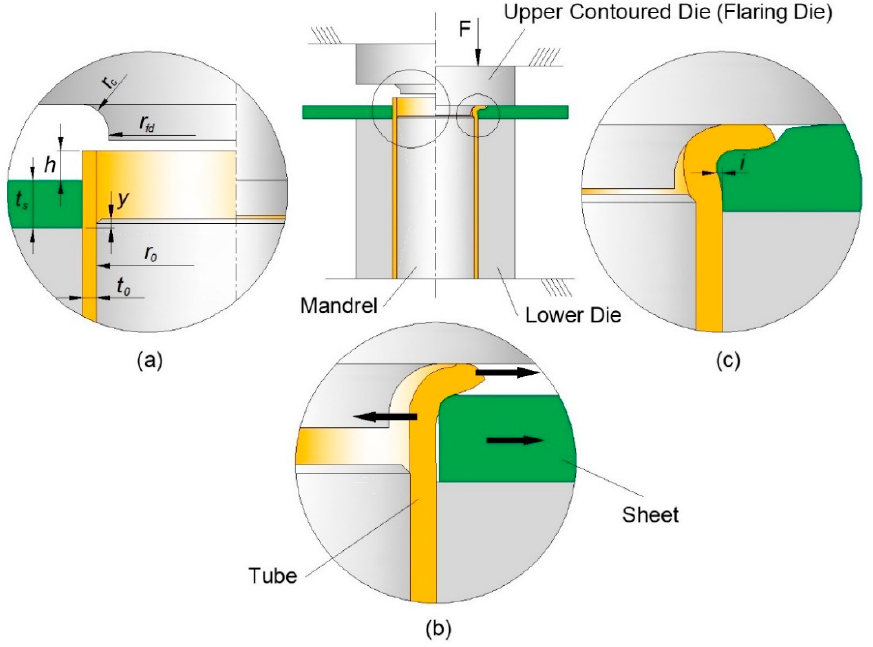
Figure 3. The new joining by forming process to perform single-stroke attachment of sheets to tube ends: ( a ) At the initial stage; ( b ) Flaring of the free tube end with the divided material flow; ( c ) Squeezing (indentation) of the tube flange against the sheet surface.